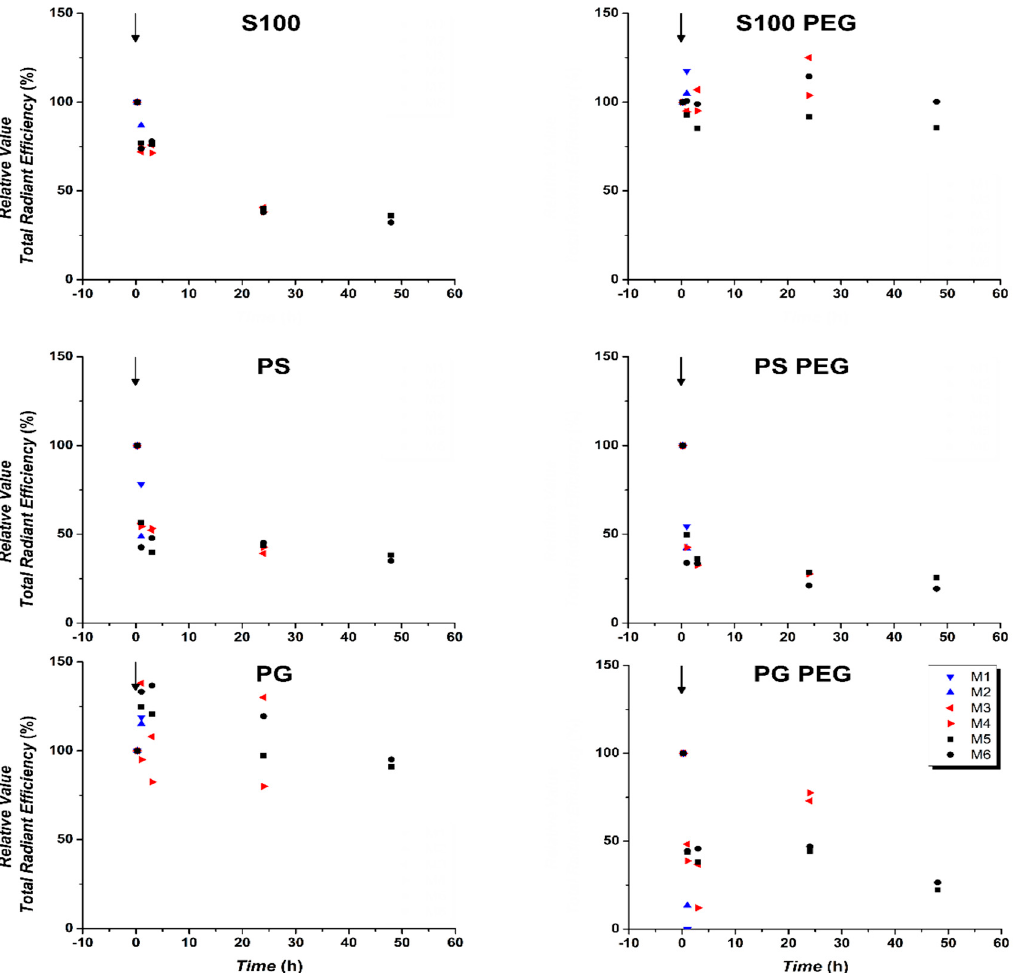
Figure 3. Quantification of in vivo fluorescence signal showed prolonged circulation of S100 PEG and fast clearance of other formulations. Signals were evaluated from defined region of interest (ROI) in DiR-loaded liposome-treated female mice (ventral perspective), as assessed by in vivo FI at 0.25, 1, 3, 24 and 48 h post injection. M1 to M6 represent individual mouse values. M1 and M2 were sacrificed at t = 1 h, M3 and M4 at t = 24 h and M5 and M6 at t = 48 h. Presented values are relative to t = 0.25 h.